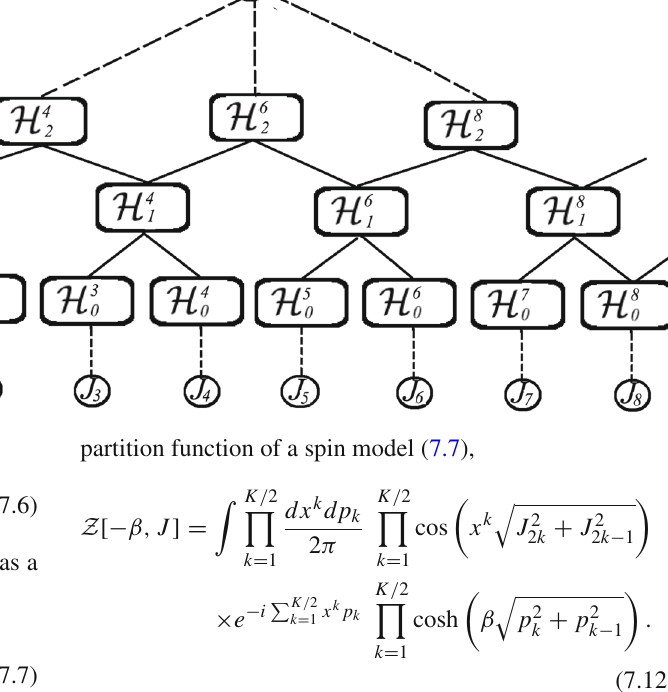
Fig. 3 Interactions network of a spin chain